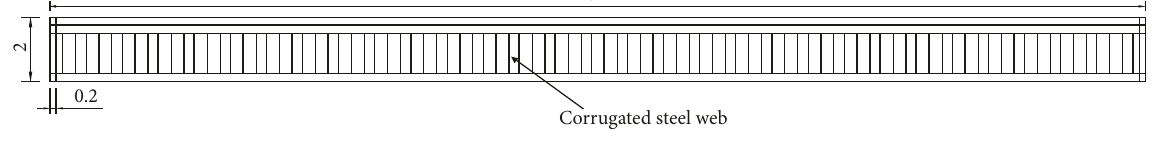
Figure 1: Longitudinal elevation of the box girder bridge with corrugated steel webs (unit: m).